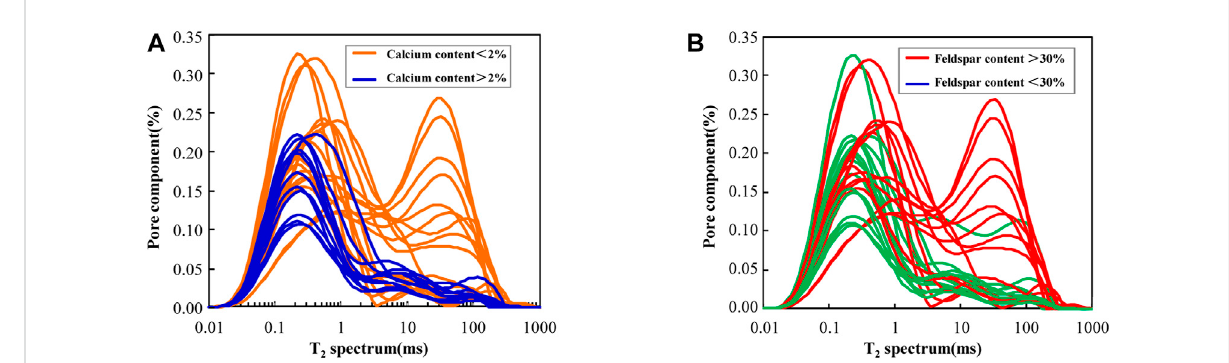
FIGURE 6 NMR T 2 spectrum of core samples with different calcium (A) and feldspar (B) content.